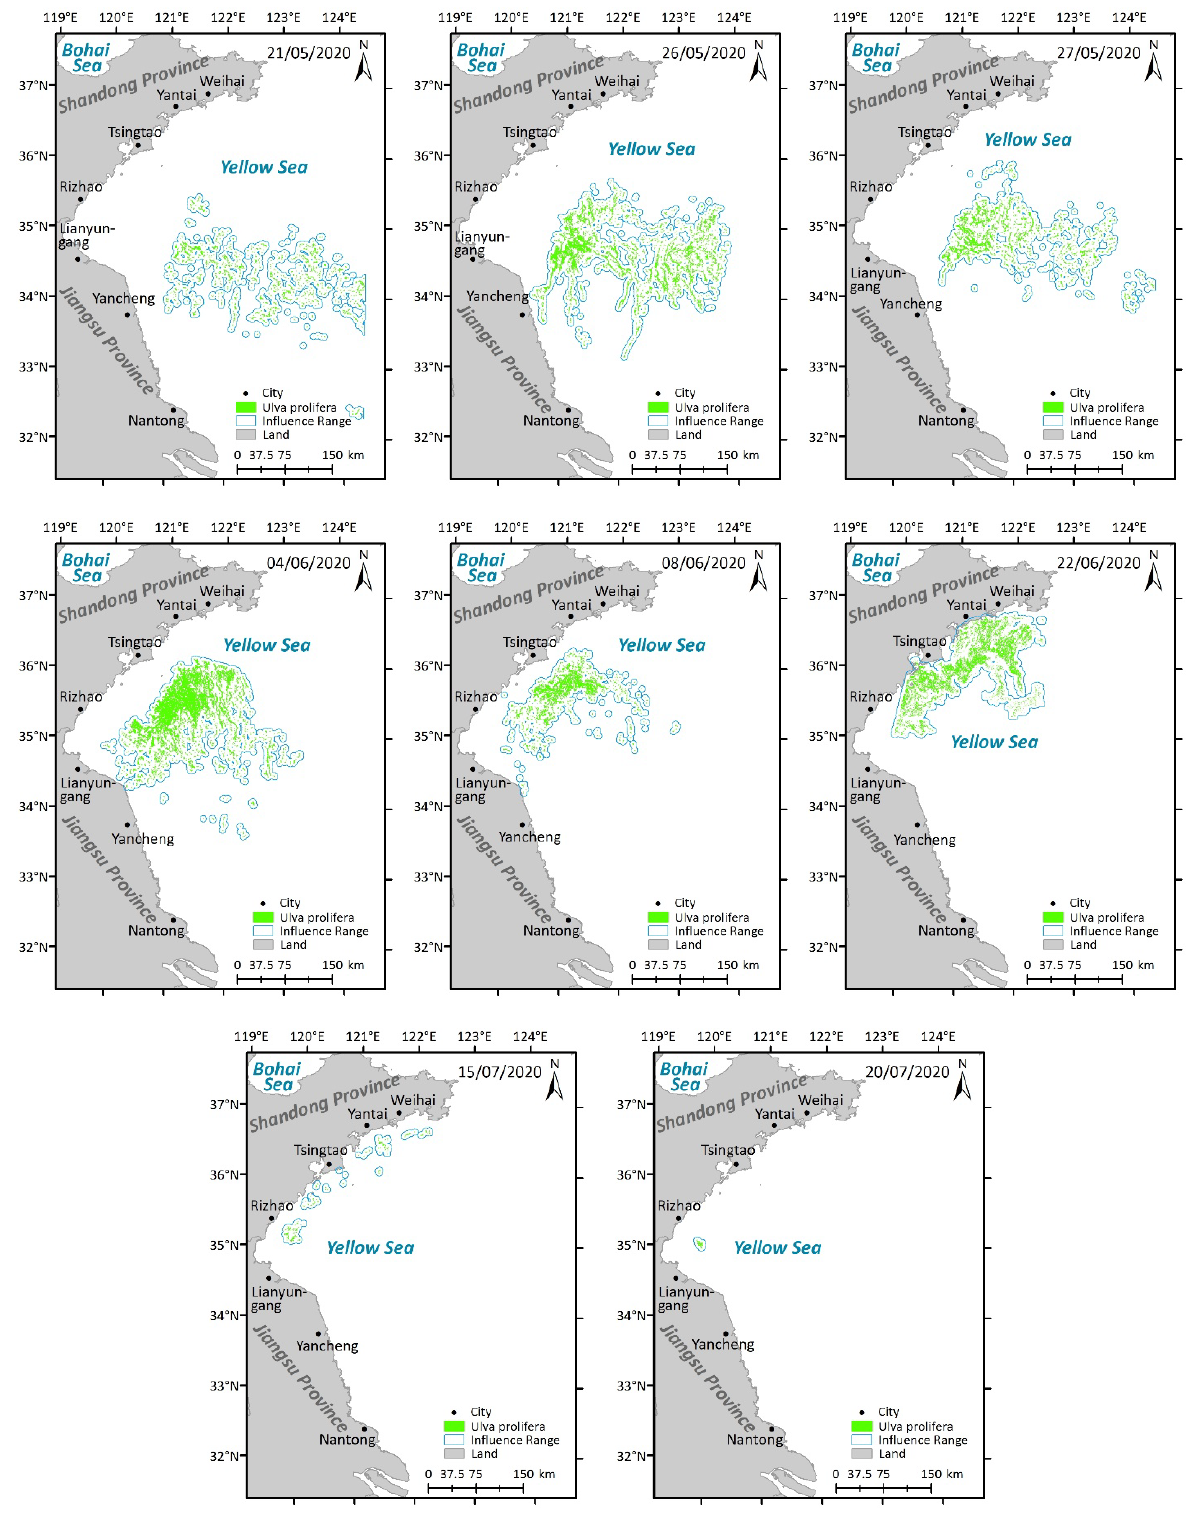
Figure 6. Spatio-temporal distribution of U. prolifera in the Yellow Sea in 2020.